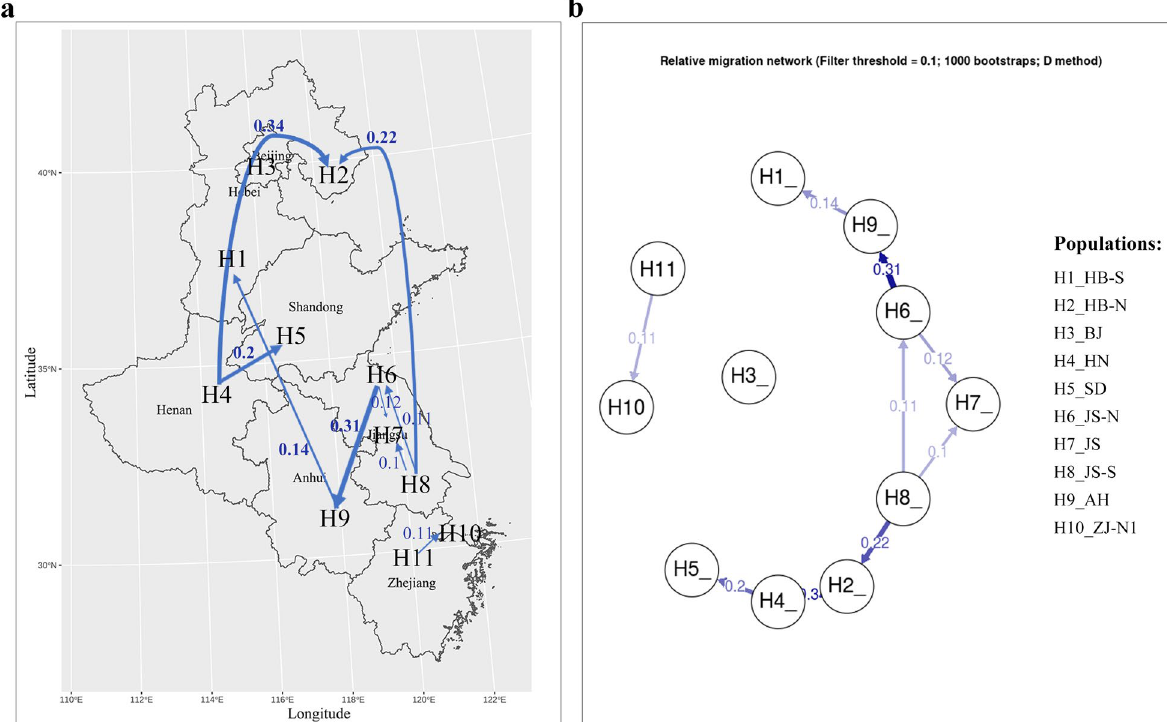
Fig. 4 Relative migration network of 11 populations reflecting the direction of gene flow in eastern China. a Abridged general view on the map. b Relative migration network with filter threshold 0.1. The arrows show the direction of gene flow between pairwise populations, and the shades of = color correspond to the values of relative gene flow